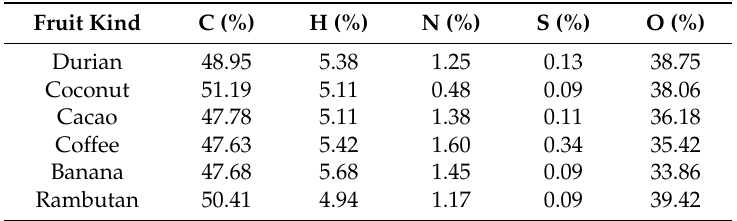
Table 7. Elemental compositions of fruit waste biomass in dry basis